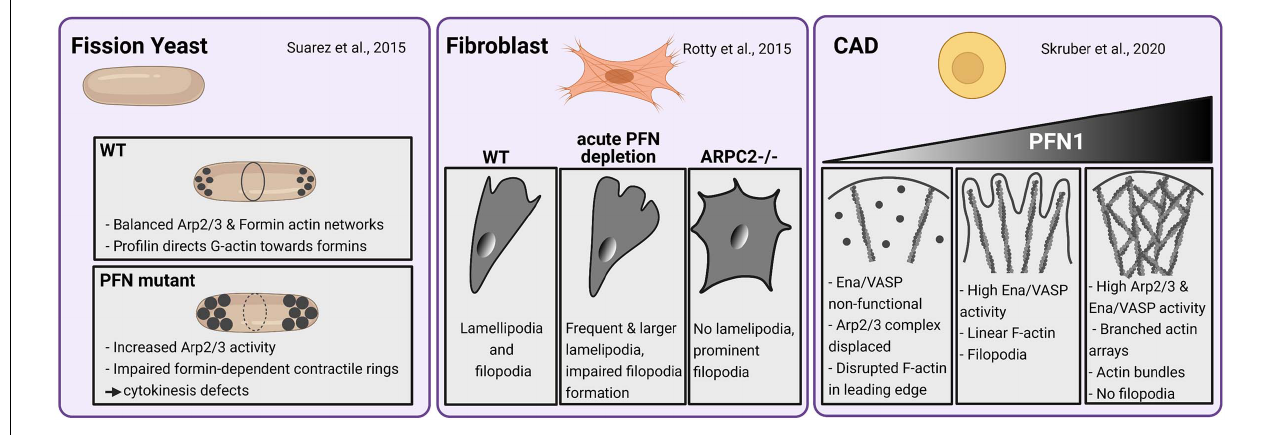
FIGURE 2 | Profilin-dependent mechanisms in coordinating different actin networks vary in a cell type-specific manner. Fission yeast (left panel) : Profilin balances ARP2/3 and Formin-dependent actin networks by directing G-Actin toward formins enabling normal contractile ring development and, thus, normal cytokinesis. Under semi-permissive temperatures, PFN mutants show large actin patches by increased ARP2/3 activity and impaired contractile ring formation and cytokinesis defects according to formin dysfunctions (Suarez et al., 2015). Mouse Fibroblasts (c enter panel) : Wildtype fibroblasts form normal lamellipodia and filopodia. An acute depletion of PFN leads to increased F-Actin levels and formation of prominent ARP2/3-rich lamellipodia. Filopodia formation is impaired in PFN1-depleted fibroblasts. ARP2-deficient fibroblasts exhibit prominent filopodia but no lamellipodia. Actin dynamics in ArpC2-deficient cells rely on PFN1 and Ena/VASP-proteins (Rotty et al., 2015). CAD cells (right panel) : PFN deficiency disrupts the actin networks in leading edges of CAD cells by rendering Mena/VASP proteins inactive and displacing the Arp2/3 complex. Rescue experiments with low to medium levels of PFN1 mediate exclusively linear actin filaments and filopodia formation by high Mena/VASP-activity. High levels of profilin in these settings evoke both high Arp2/3 and Mena/VASP activity. Thus, dense branched actin arrays are formed along with linear actin bundles. The latter resembled filopodia precursors while actual filopodia were not formed (Skruber et al.,